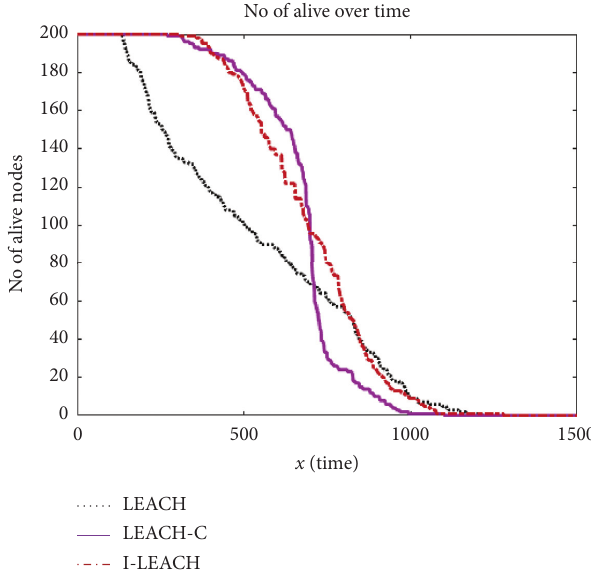
Figure 6: Comparison of the number of alive nodes under the three